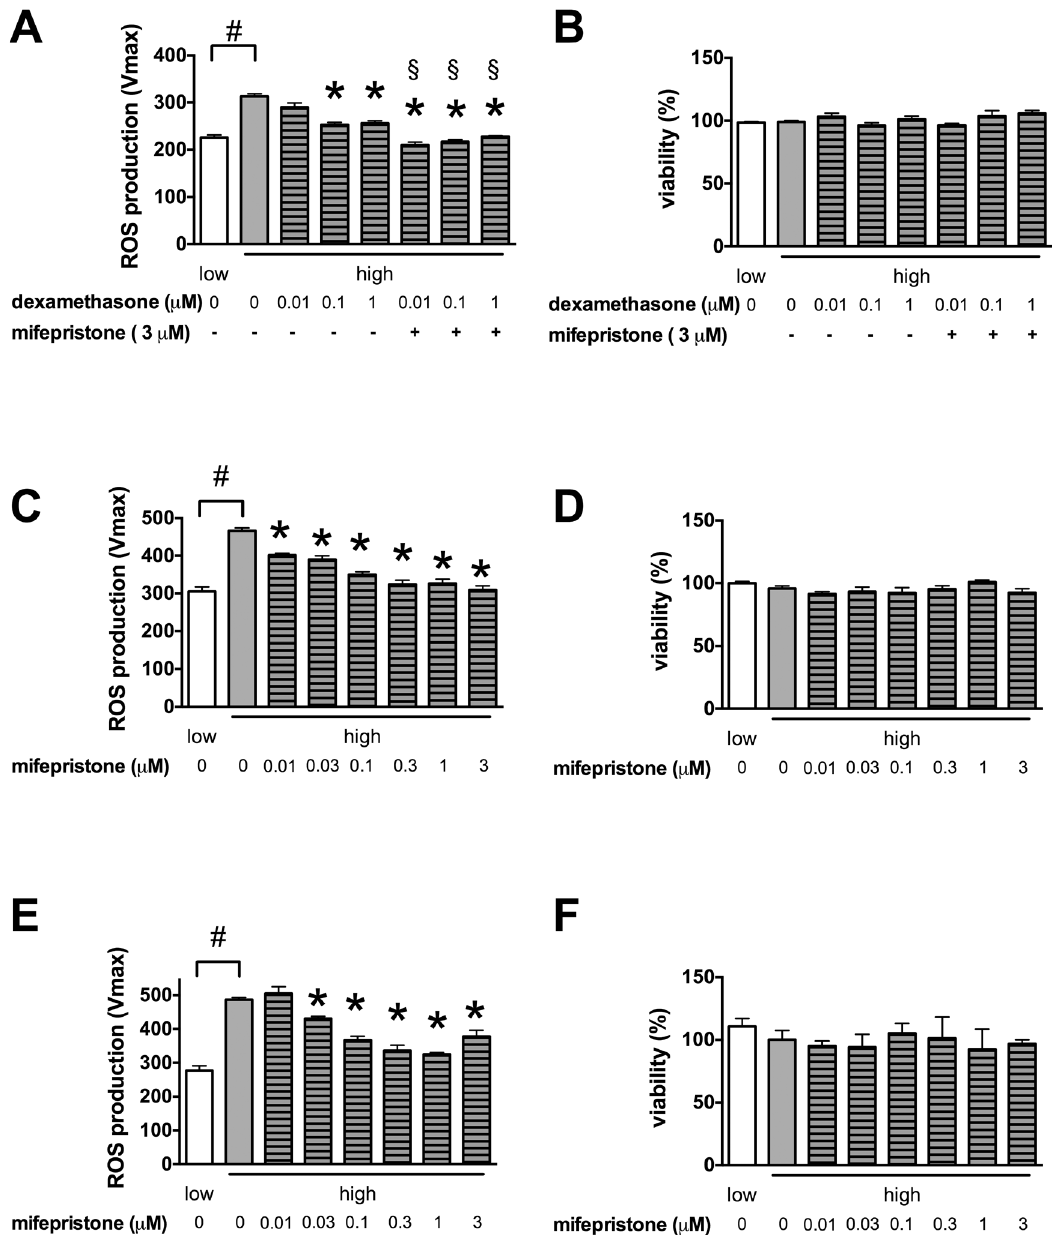
Fig 3. Mifepristone inhibits the glucose-induced mitochondrial ROS production in microvascular endothelial cells. A-D: b.End3 microvascular endothelialcells were exposed to highglucose for 7 days and were treatedwith dexamethasone and mifepristone ( A, B ) or with mifepristone alone ( C, D ) at the indicated concentrations for 3 days. A, C: The ROS production was measured with the mitochondrial superoxide specific MitoSOX Red B, D: The viability was determined by measuring the Hoechst 33342 DNA dye uptake. E, F : bEnd.3 BALB/c murine microvascular endothelial cells were exposed to high glucose for 7 days and were treatedwith mifepristone for 3 days at the indicate concentrations. E : Themitochondrial ROS production was measured by MitoSOX Redand F : the viability was determined by the Hoechst 33342uptake. (#p < 0.05 high-glucose exposure induced significant changes compared to cells maintained in low glucose containing medium, * p < 0.05 glucocorticoid treatment significantly reduced the ROS production, §p < 0.05 mifepristone induced significant reduction in the ROSgeneration compared to dexamethasone alone.)